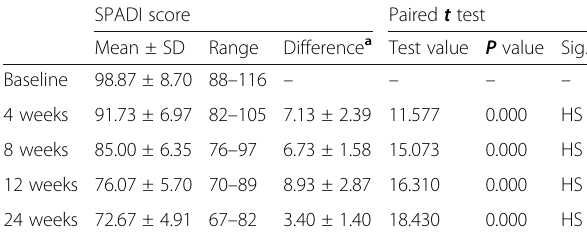
Table 1 Comparison between the baseline SPADI score and its follow-up at 4, 8, 12, and 24 weeks SPADI score Paired t test Mean ± SD Range Difference a Test value P value